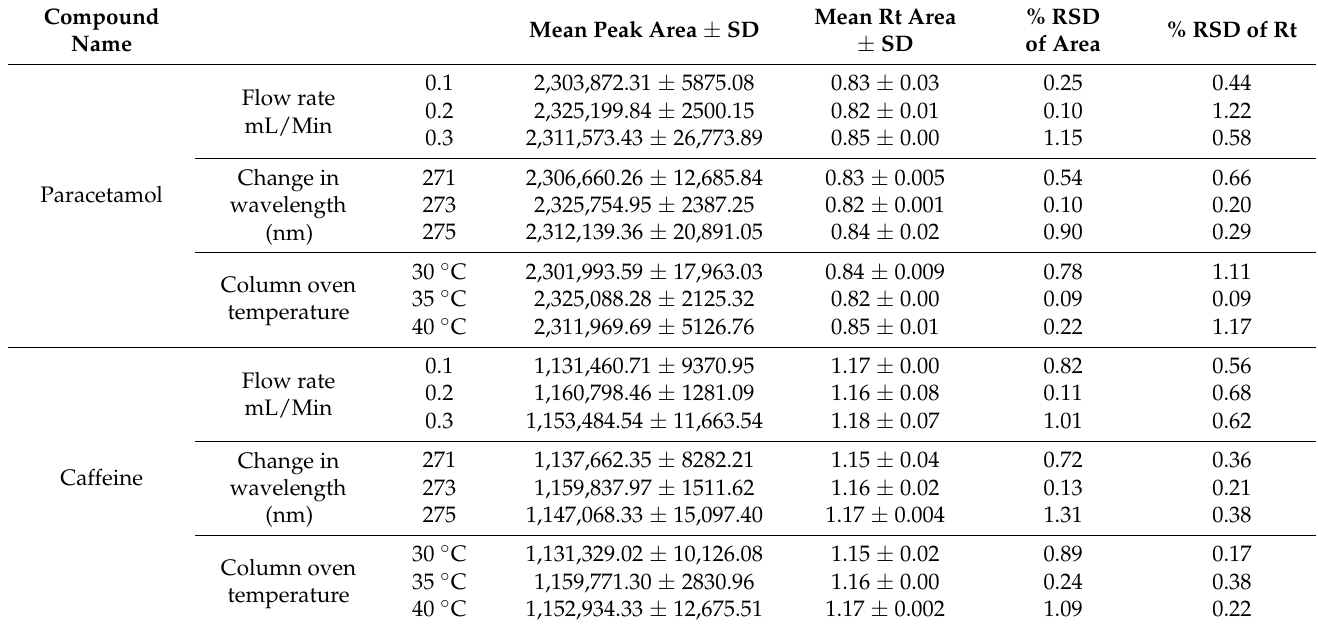
Table 4. Results of robustness of PCM and